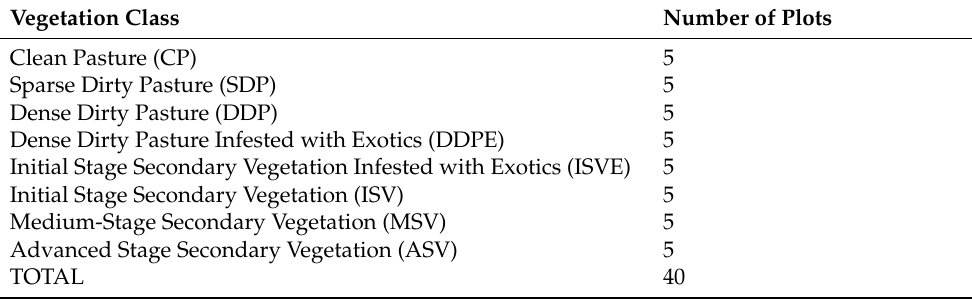
Table 1. Classes of vegetation used for the distribution of plots and number of plots sampled. Vegetation Class Number of Plots